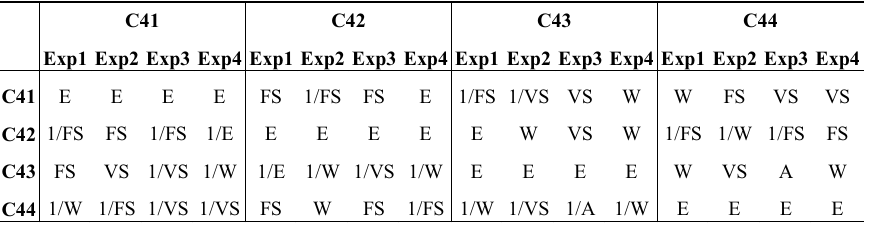
Table 12: Expert Evaluations of sub-criteria (C41-C44) with respect to Decision related factors